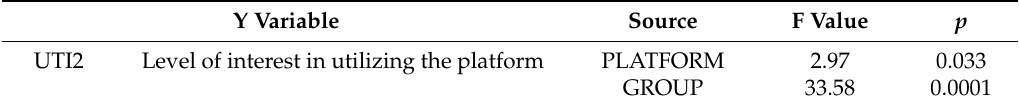
Table 1. Model with UTI2 “Level of interest of the participant in utilizing the platform”. Y Variable